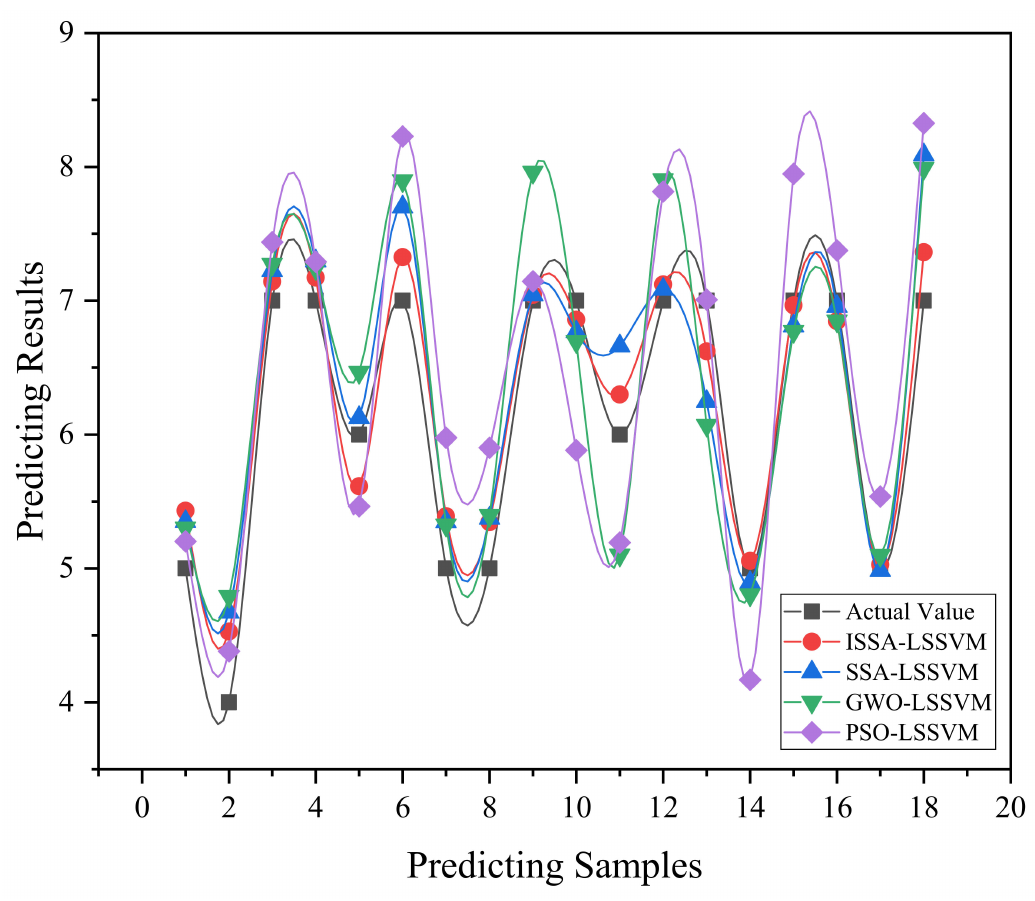
Figure 5. Comparison of prediction